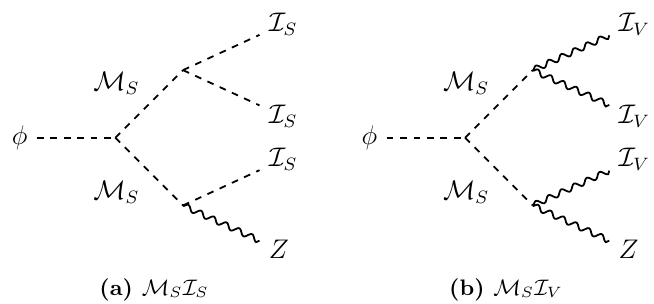
Figure 6. Mono- Z + E miss